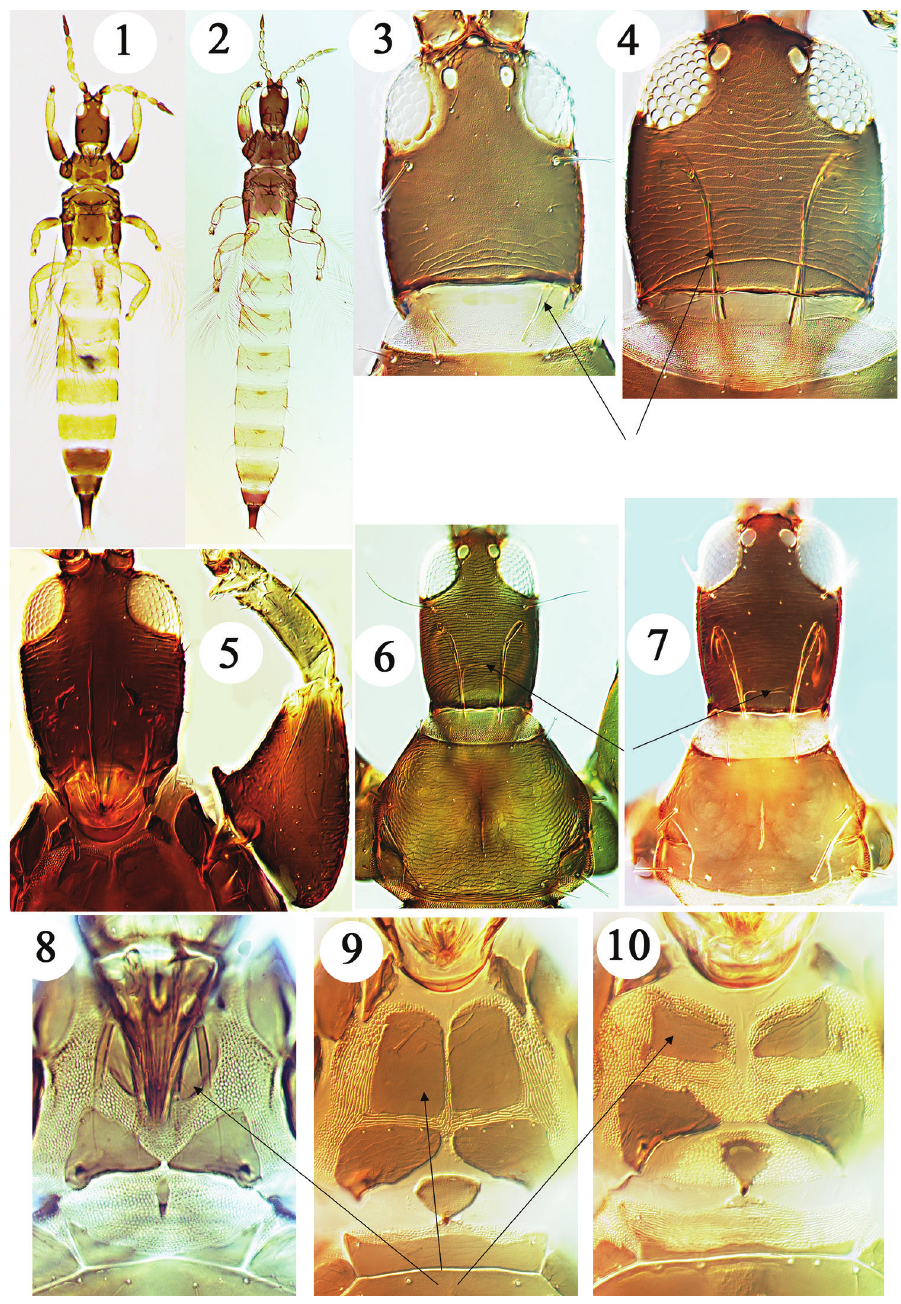
Figures 1–10. Haplothripine species from Hawaii. 1 Bamboosiella cingulata female 2 Karnyothrips mela- leucus female 3 B. cingulata head 4 Haplothrips leucanthemi head (maxillary stylet indicated) 5 Androthrips ramachandrai female head and fore leg 6 Dolichothrips franae head and pronotum 7 D. indicus head and pronotum (maxillary bridge indicated) 8 D. indicus mouth cone and prosternites 9 Podothrips lucasseni prosternum 10 Haplothrips davisi prosternum (basisterna indicated by arrows